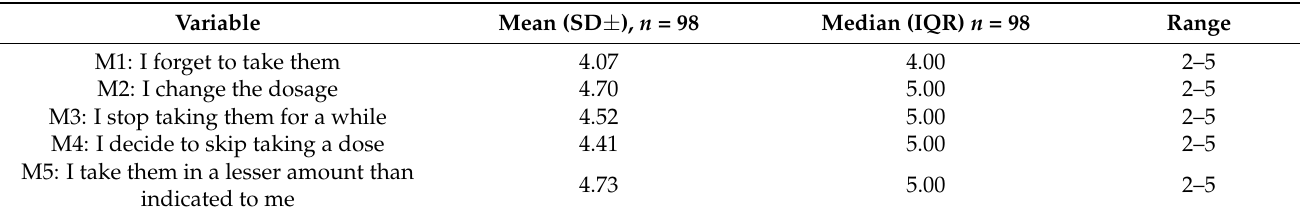
Table 4. Descriptive statistics of individual items of MARS-5I.